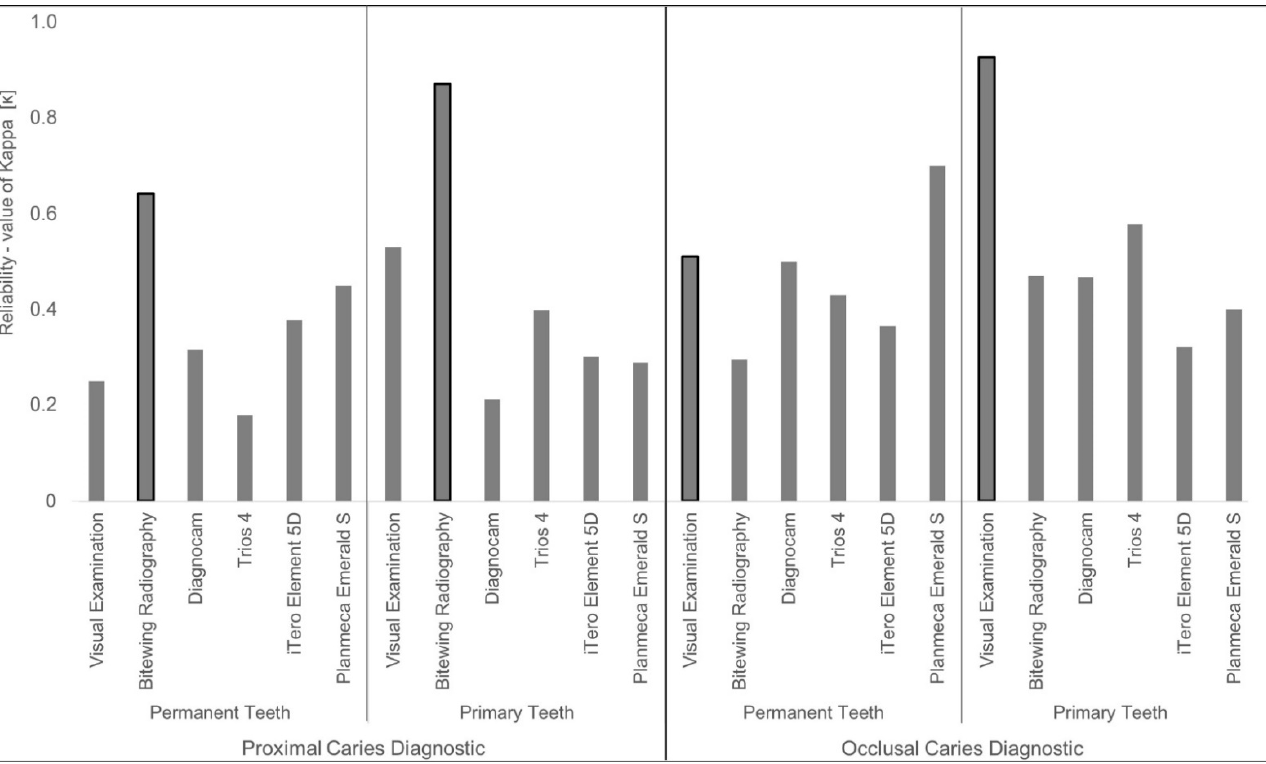
Figure 3. Bar graph of the reliability of the different diagnostic methods for permanent and primary teeth of proximal caries lesions and occlusal caries lesions; the respective gold standard methods are highlithed with framing of bars in bold typography.